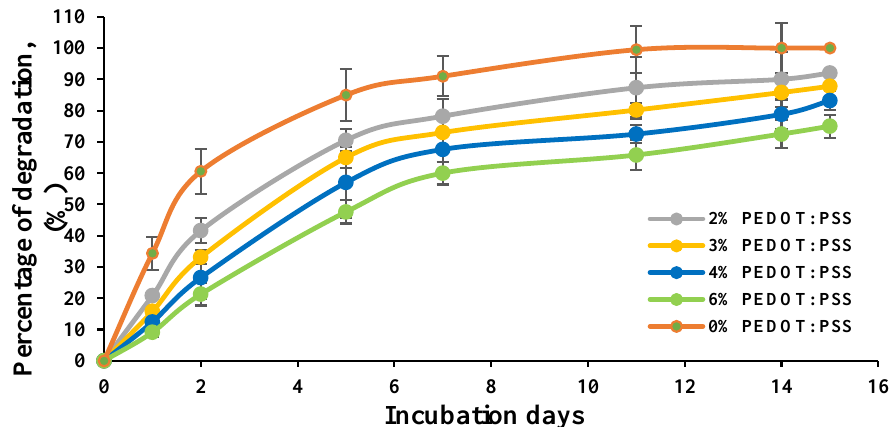
Figure 13. Degradation as measured by the weight loss of the CH films soaked in cell culture medium. The existence of PEDOT:PSS improved the CH degradation behaviour significantly.